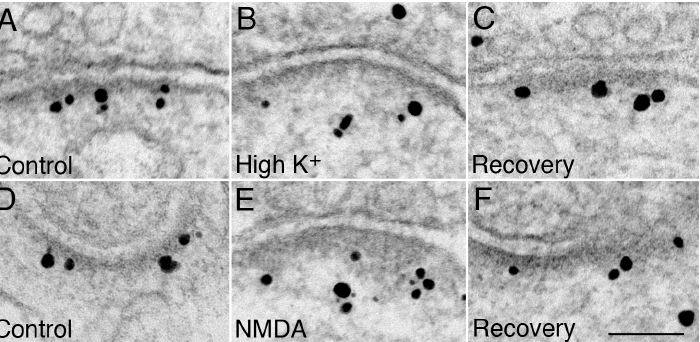
Fig 2. Electron micrographs of asymmetric synapses in dissociated hippocampal neuronal cultures immunogold labeled for AIDA-1. Antibody 1 was used in samples depicted in the upper row (A-C) and antibody 2 was used in samples depicted in the lower row (D-F). Dark grains of heterogeneous size are silver enhanced gold particles representing AIDA-1 label. Cultures were treated with either control medium (A and D), high K + (B and C) or NMDA (E and F) for 2 min, and then either fixed immediately (A,B,D,E) or let to recover for 30 min in control medium (C and F) before fixing. Scale bar = 0.1 μ m.